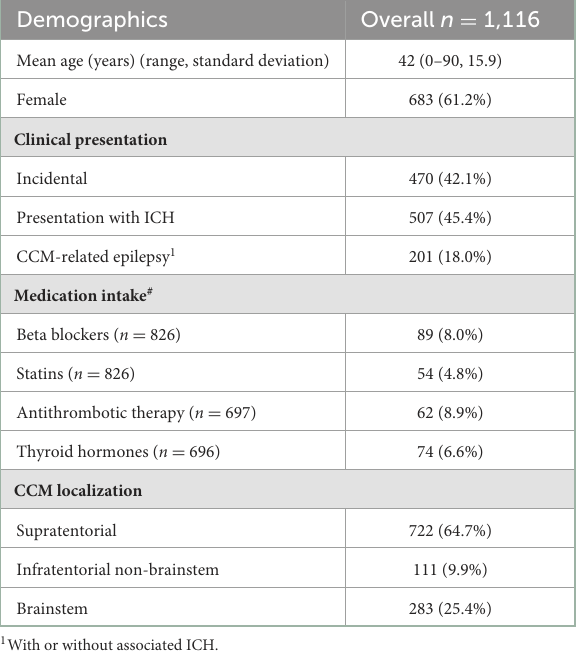
TABLE 1 Baseline characteristics of 1,116 patients with CCM.